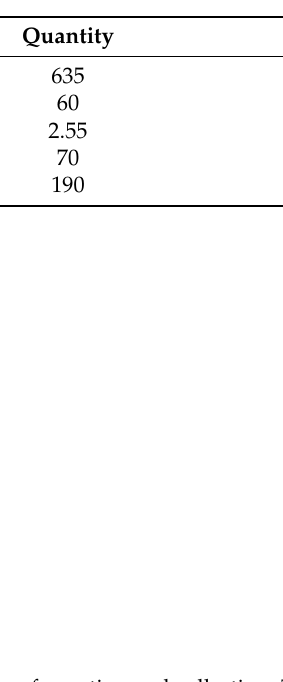
Table 3. Basic parameters of the fiber laser.